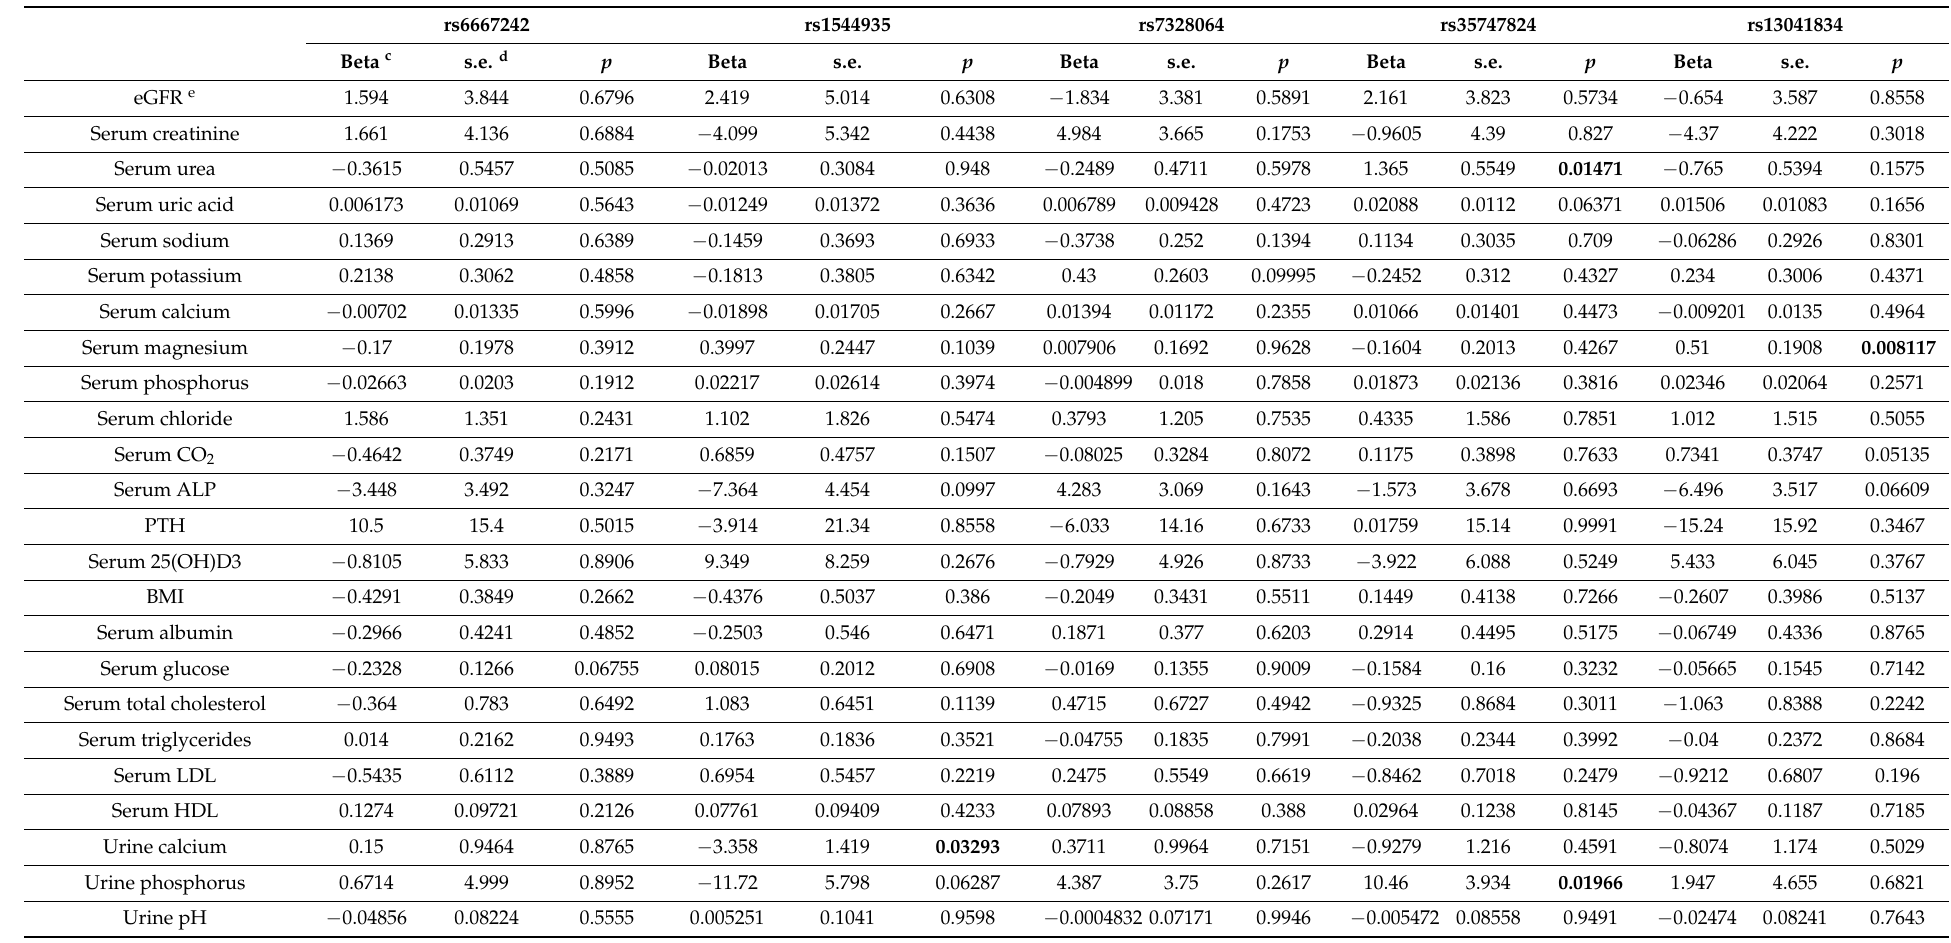
Table 4. Multiple linear regression analyses for clinical